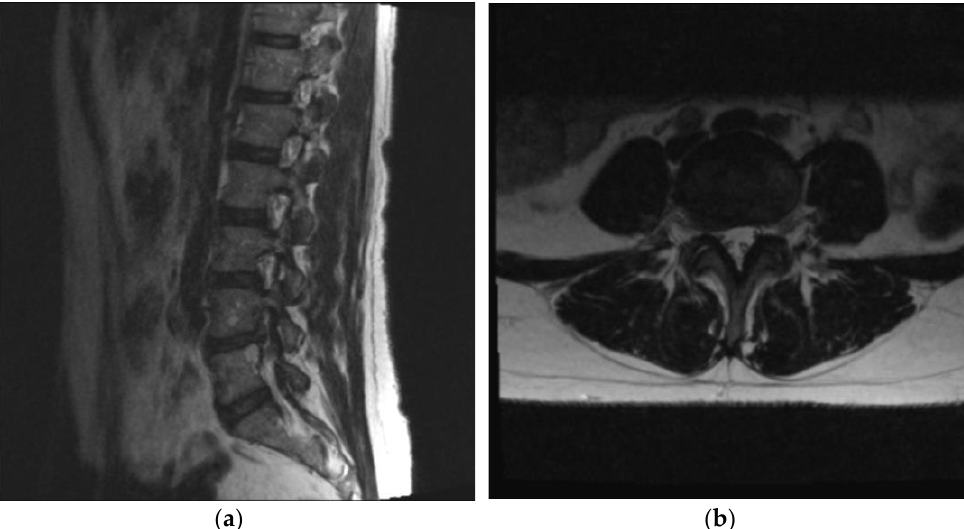
Figure 1. T2 weighted Magnetic Resonance Imaging (MRI). ( a ) Sagittal sequence demonstrating se- vere foraminal stenosis at L4 – 5 with cephalad disc extrusion; ( b ) axial cut at the L4 – 5 disc level also demonstrating right-sided far lateral disc herniation. demonstrating right-sided far lateral disc